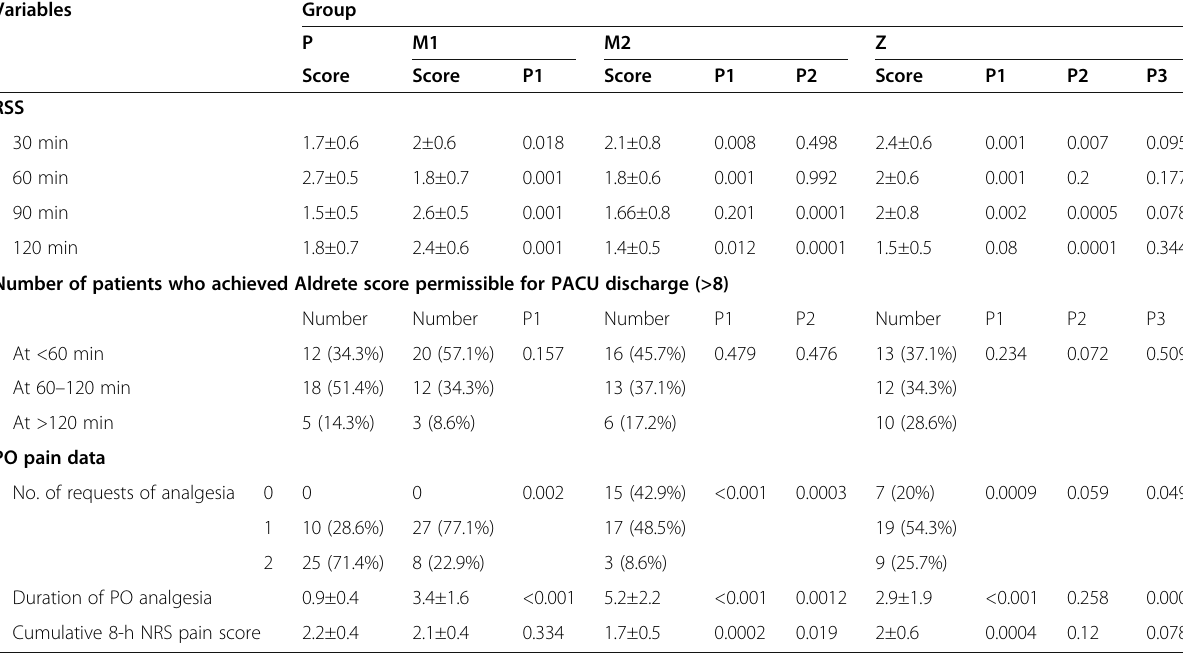
group. PO hospital stay for patients of M1 group was non-significantly shorter and longer in comparison to patients of P and Z groups, respectively, while was sig- nificantly shorter for patients of Z group in comparison to patients of P group. The frequency of patients among higher satisfaction grades was significantly ( p =0.009) Table 3 PO sedation and pain data of patients of the four groups Variables Group